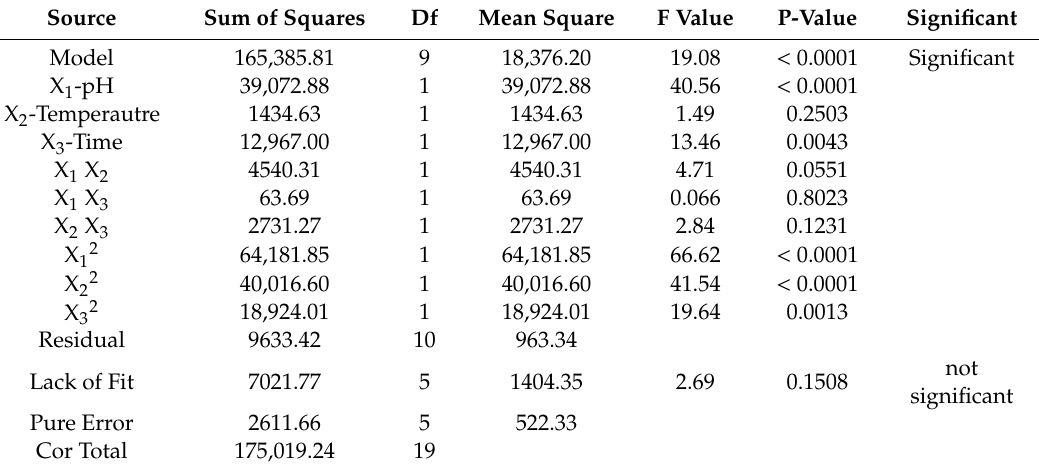
Table 2. Analysis of variance (ANOVA) of the fitted polynomial quadratic